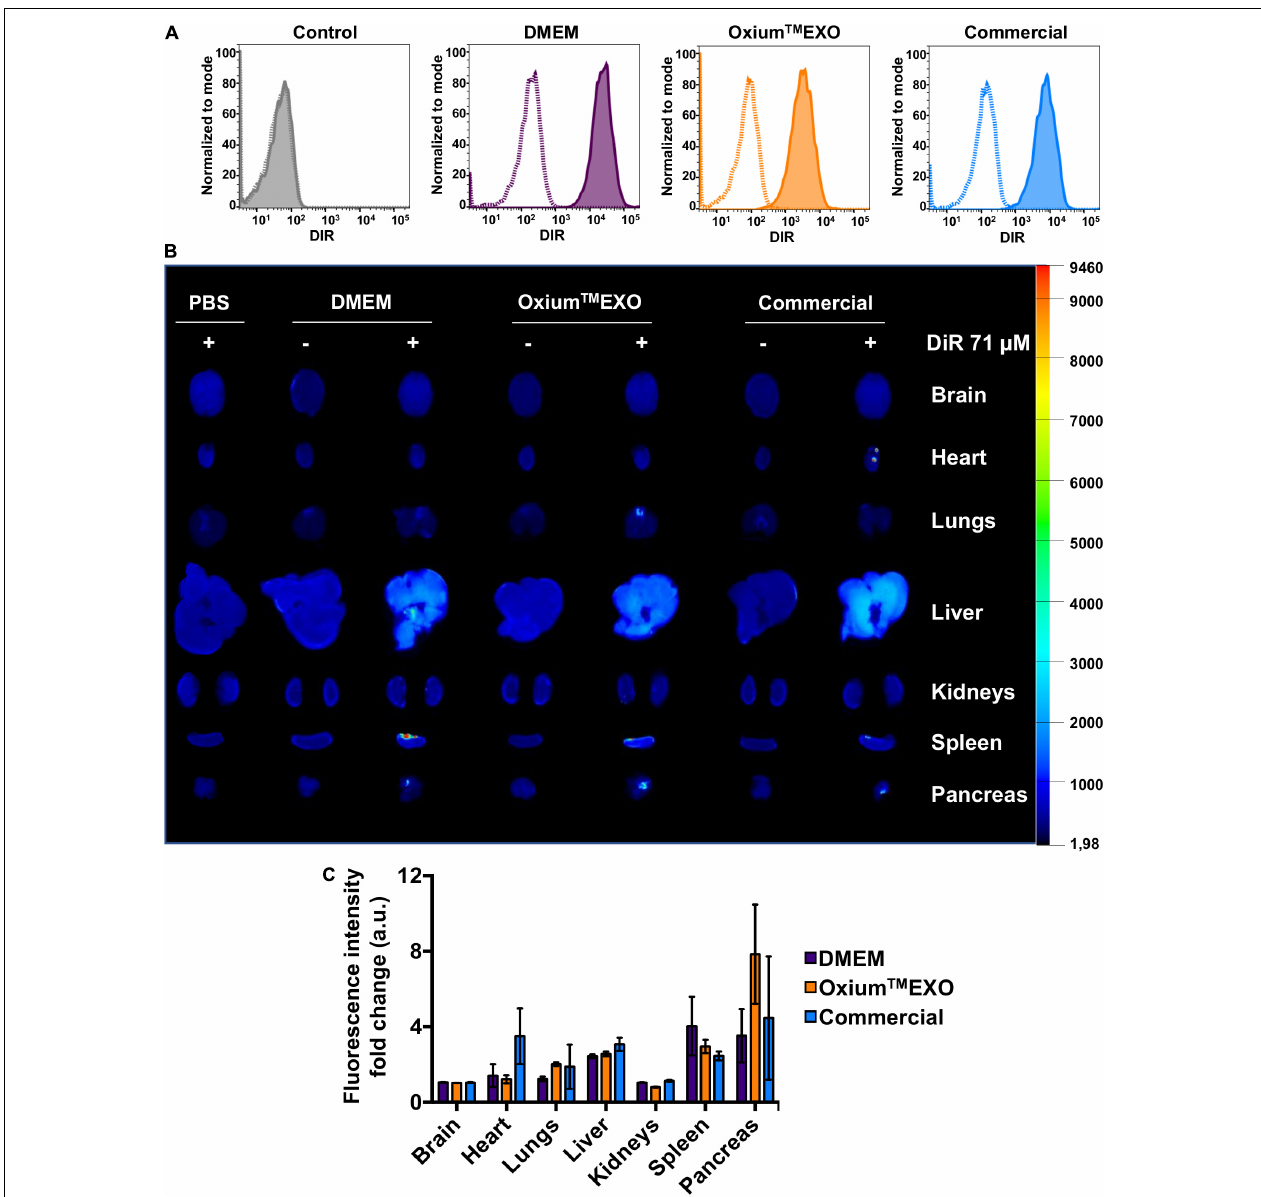
FIGURE 4 | Cellular internalization and in vivo biodistribution profile of isolated sEV produced in DMEM, Oxium TM EXO, and commercial medium. (A) Flow cytometry analysis of MDA-MB-231 cancer cells incubated for 6 h with DiR-stained isolated sEV. Dotted lines = incubation performed at 4 ◦ C; solid lines = incubation performed at 37 ◦ C; gray histogram = no sEV-incubation control (PBS + DiR); violet histogram = DMEM-derived sEV uptake; orange histogram = Oxium TM EXO-derived sEV uptake; light blue histogram = commercial medium-derived sEV uptake. (B) Six hours post-injection distribution of DiR-stained isolated-sEV administrated intraperitoneally in mice. (C) Fluorescence intensity-fold change observed for each analyzed organ. The fluorescence intensity of DiR-stained sEV-treated mouse organs was normalized with the fluorescence intensity of those organs coming from mice treated with the respective unstained sEV. The graph shows mean ± SEM. n = 3 mice for each